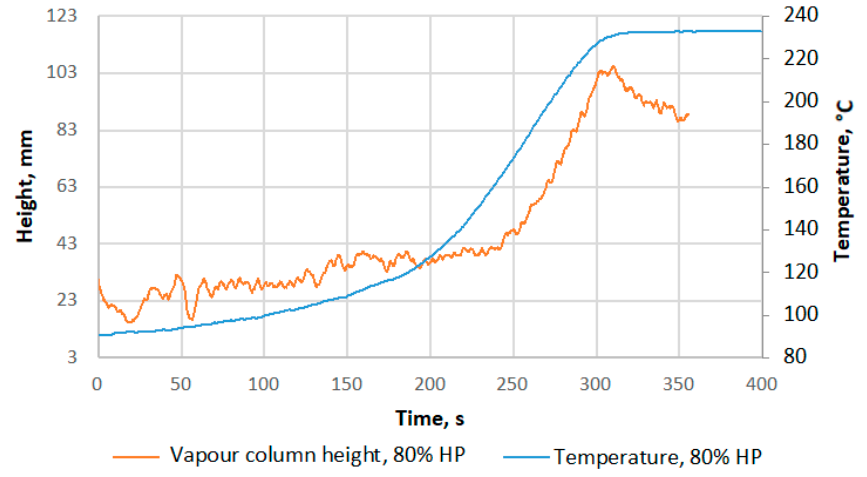
Figure 6. The height derived from pressure results and temperature measurement during the heating phase inside the workspace of a heat-level VPS oven with 80% heating power (HP). With the detection of the pressure peak, we are able to enable a faster medium type recognition process in the working cycles of the oven. The recorded temperature is repre- senting the boiling point of the medium when the pressure peak appears.